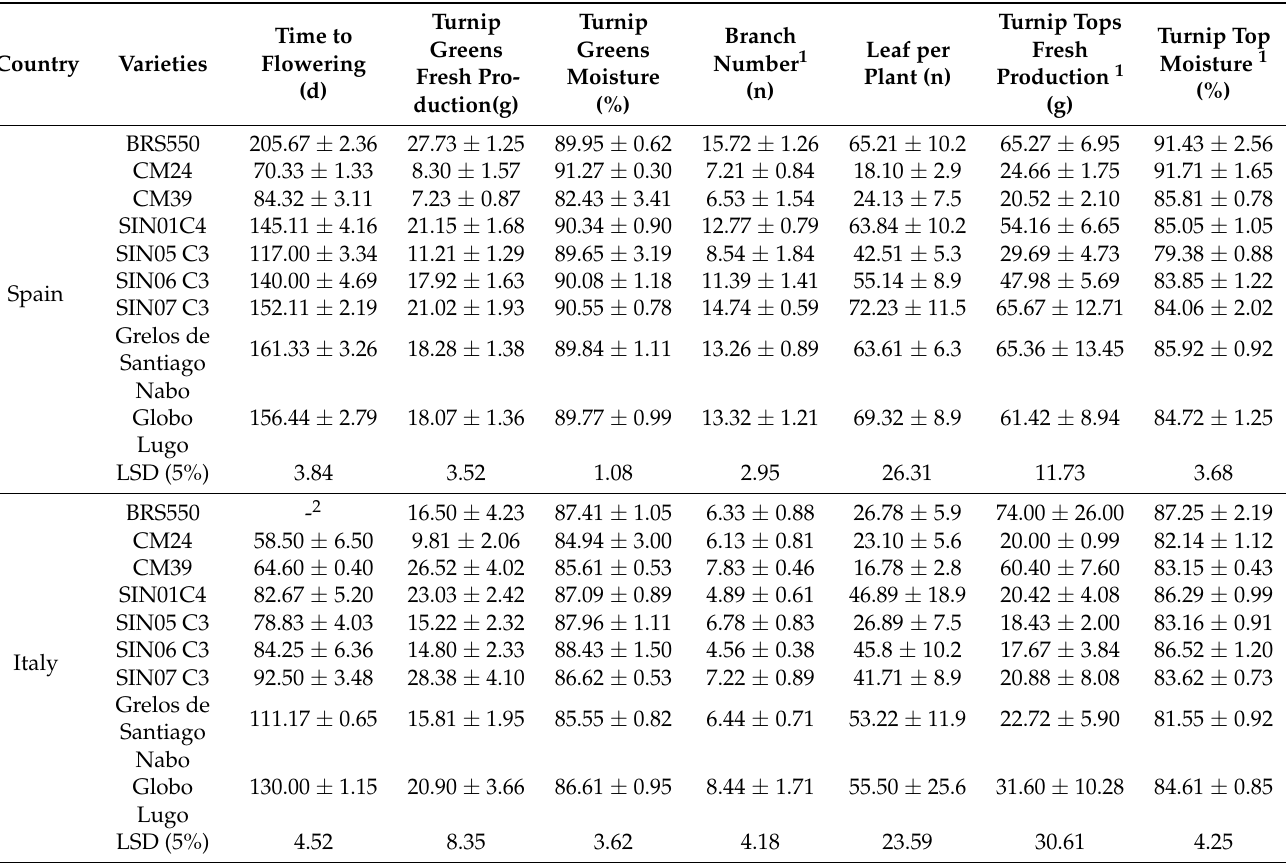
Table 3. Means of several agronomical traits of nine Brassica rapa genotypes evaluated at three environments in Northwestern Spain and two environments in